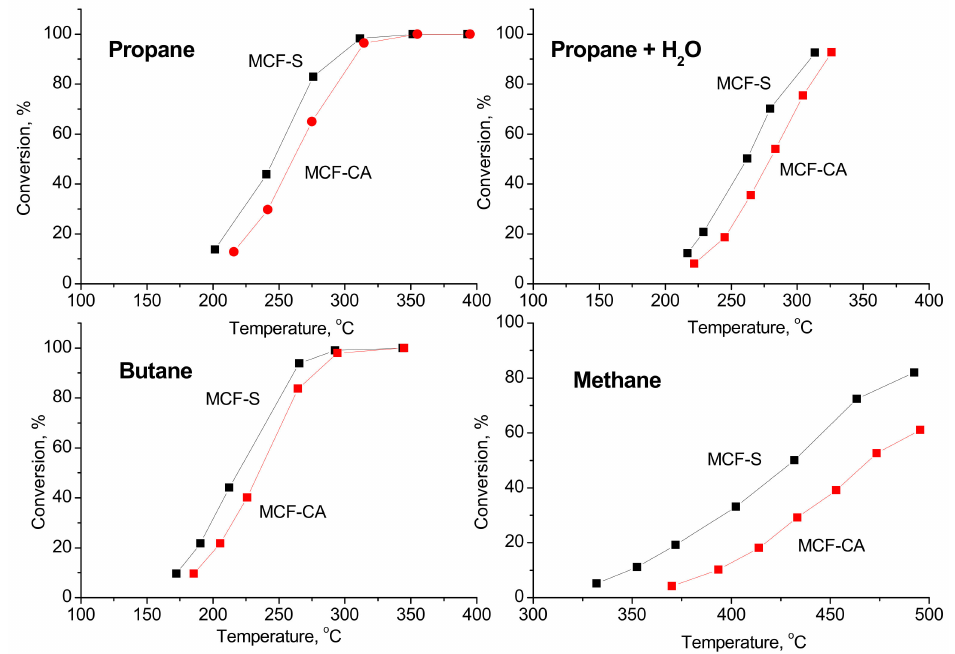
Figure 7. Dependence of the conversion degree on the reaction temperature during the complete oxidation of hydrocarbons on MCF-S and